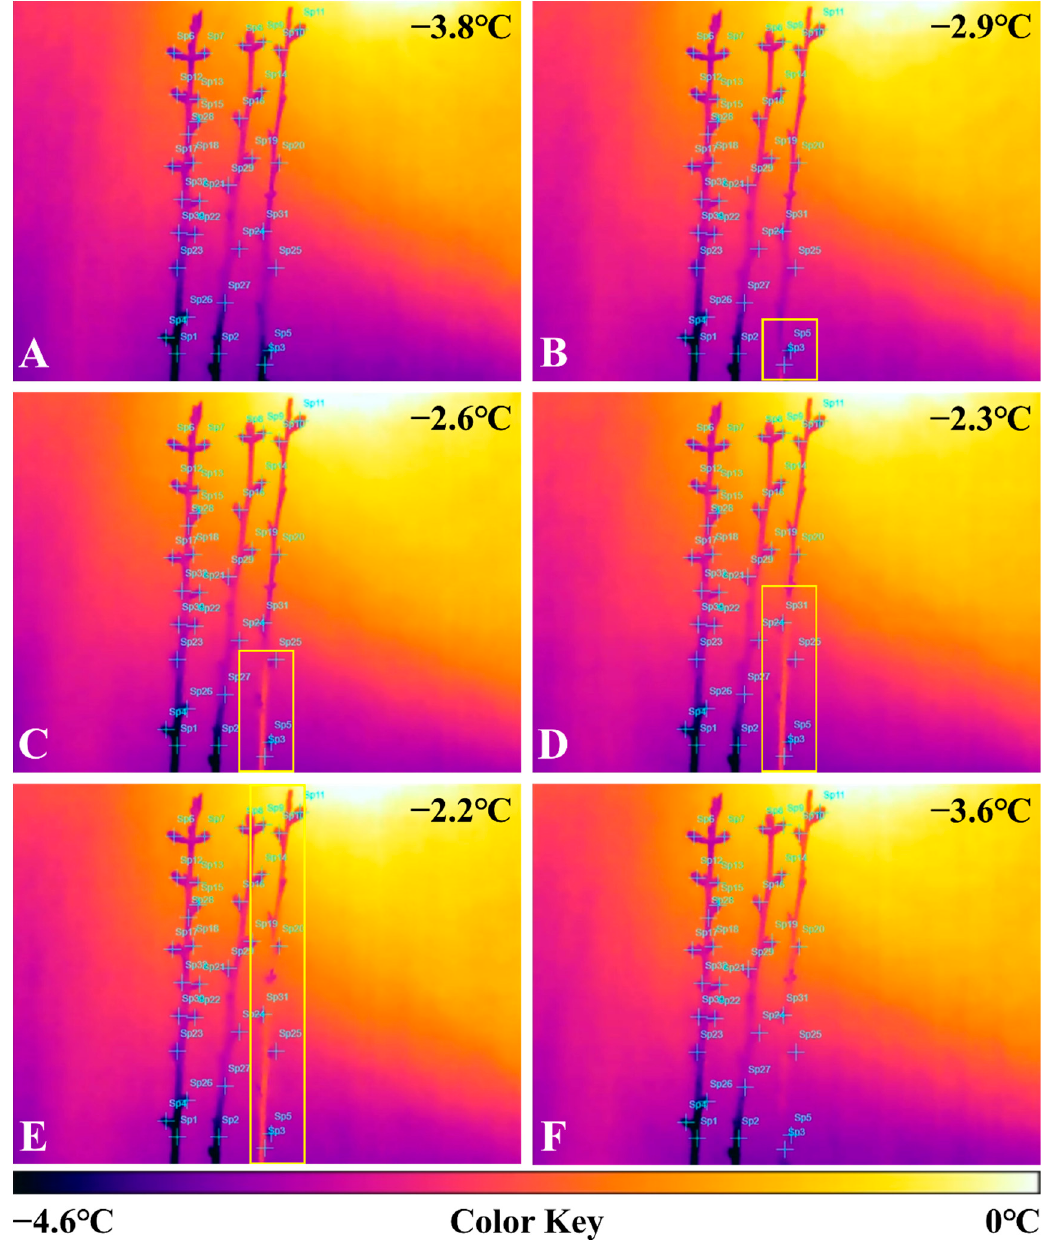
Figure 1. Visuals of the thermal changes in excised ‘Daewol’ peach shoots ( A – F ) suffering frost damage from 1 to − 4 °C for 4 h. In each step, each event after expressing exothermic behavior occurred at about 20 s ( B – E ). Finally, about 15 min elapsed for the temperature to drop to − 3.6 °C ( F ).